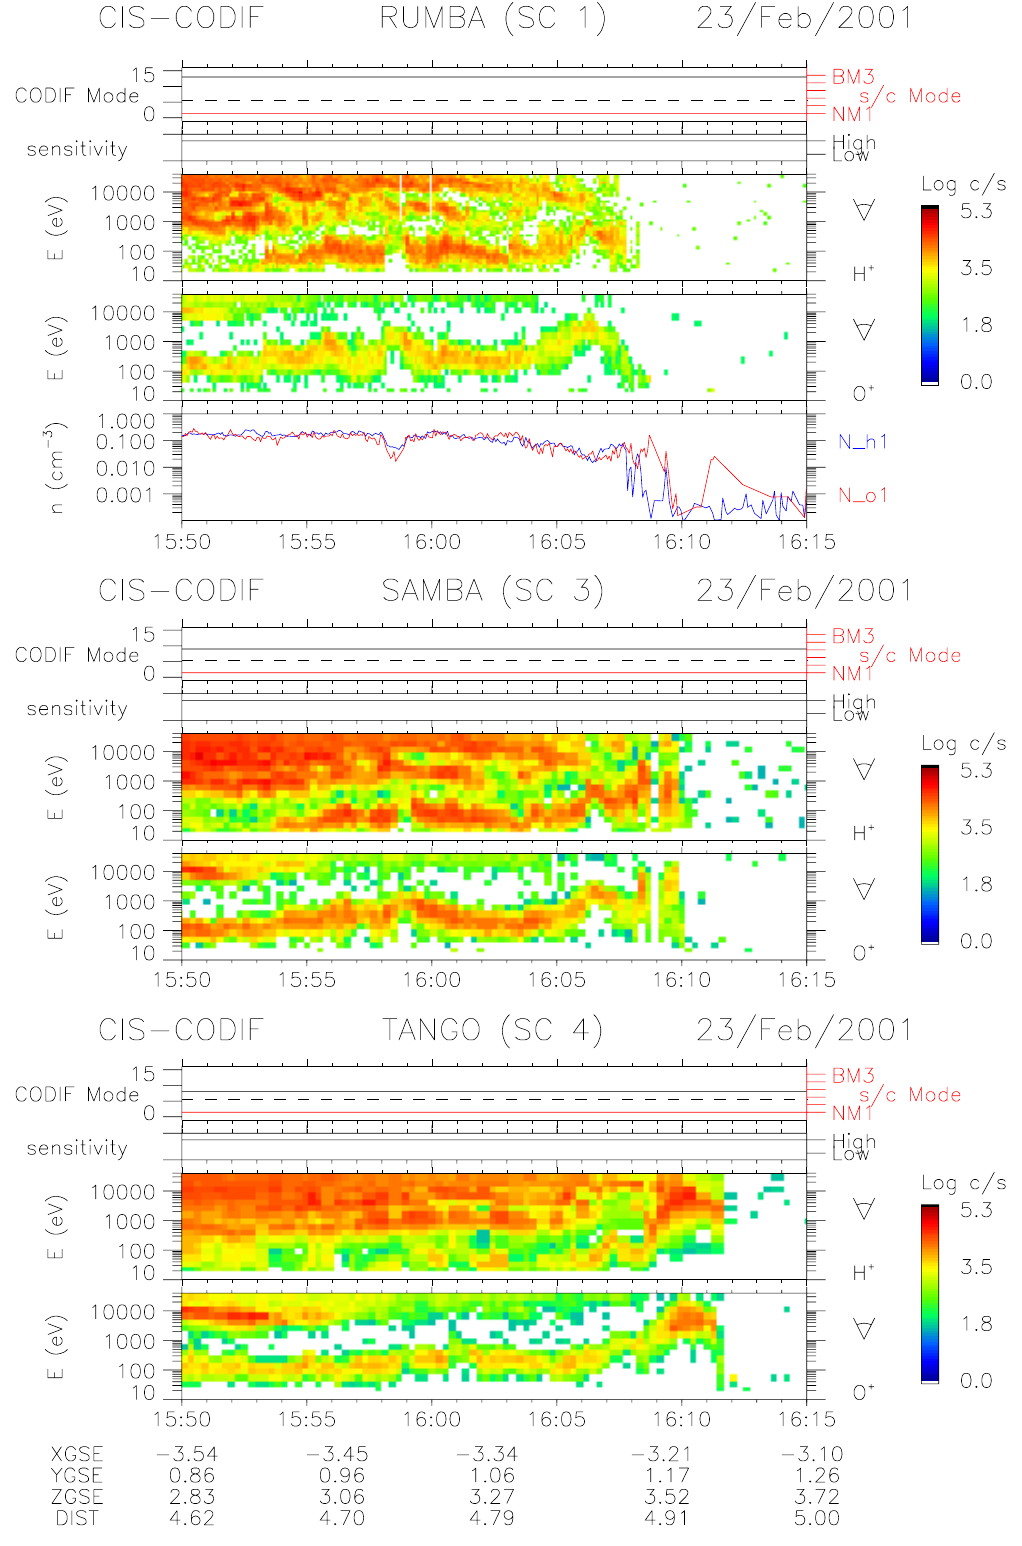
Fig. 38. CODIF H + and O + measurements on spacecraft 1 (upper panel), 3 (middle panel), and 4 (lower panel), on 23 February 2001, between 15:50 and 16:15UT. Each panel shows telemetry modes and sensitivities, energy-time spectrograms for upflowing H + and O + ions and H + and O + ion